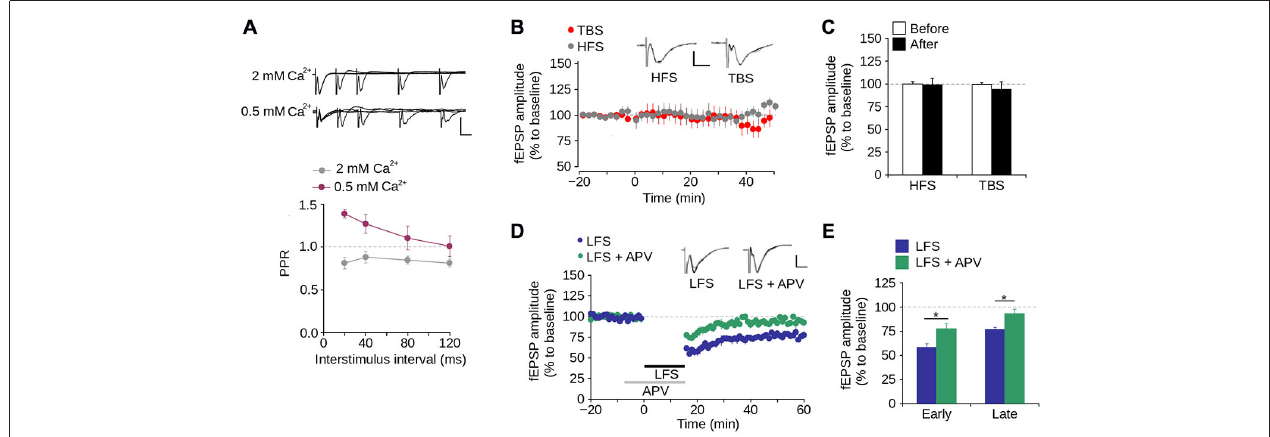
FIGURE 3 | Synaptic plasticity in layer 1 of the mPFC. (A) Upper panel, Superimposed representative fEPSP traces evoked by paired-pulse stimulation (PPS) at different inter-stimulus intervals (ISI) between 20–120 ms in ACSF containing either 2 mM or 0.5 mM [Ca 2 + ] (Scale bar: 1 mV; 10 ms). Lower panel, quantification of paired-pulse ratio (PPR) at different ISI for 2 and 0.5 mM [Ca 2 + ] in the ACSF. (B) Time lapse of the average fEPSP amplitude expressed in percentage of the baseline before theta-burst stimulation (TBS) or high-frequency stimulation (HFS). Inset: superimposed representative fEPSP traces evoked before and after TBS or HFS (Scale bar: 0.5 mV; 5 ms). (C) Bar chart of the average change of fEPSP amplitude expressed as percentage ten minutes before and 40 min after the application of either TBS or HFS. (D) Time lapse of normalized fEPSP amplitude expressed as percentage of the baseline. The application of low-frequency stimulation protocol (LFS; 900 pulses at 1 Hz, indicated by the black bar) depressed the fEPSP amplitude. This depression was blocked by the application of 50 µ M APV in the perfusion bath, ten minutes before and during the application of the LFS protocol (indicated by the gray bar). Inset: superimposed representative traces recorded before and after LFS for both normal and APV conditions (Scale bar: 0.5 mV; 5 ms). (E) Bar chart of the average normalized fEPSP amplitude recorded during the first 10 min (early-LTD) and last 10 min (late-LTD) after the application of the LFS protocol ( ∗ p < 0.05; Bonferroni post hoc comparison after ANOVA; n = 9 per group). Data are expressed as mean ± SEM ( n = 4 animals, 17-23